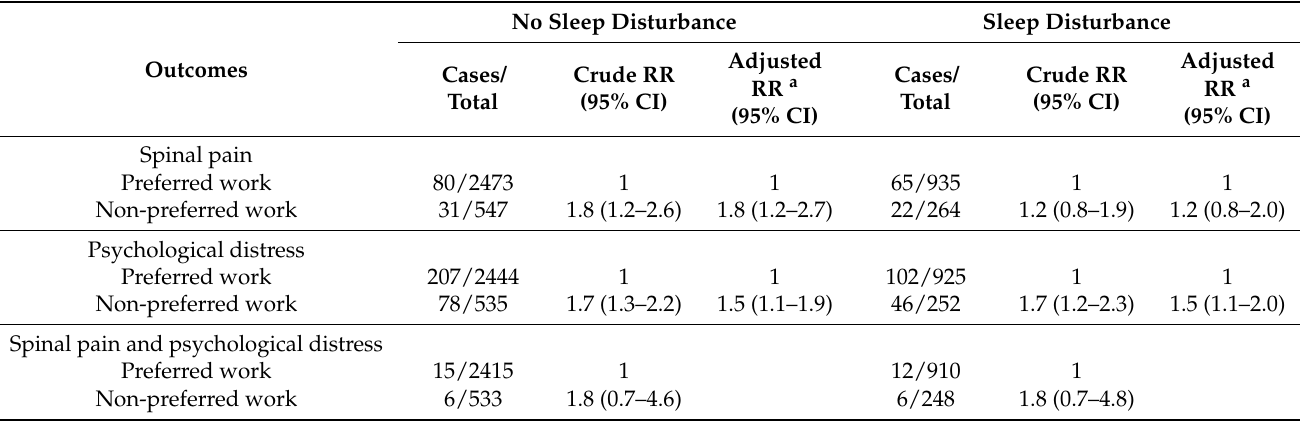
Table 4. Associations between non-preferred work and the incidence of spinal pain, psychological distress and spinal pain with concurrent psychological distress, stratified by sleep disturbance (n =